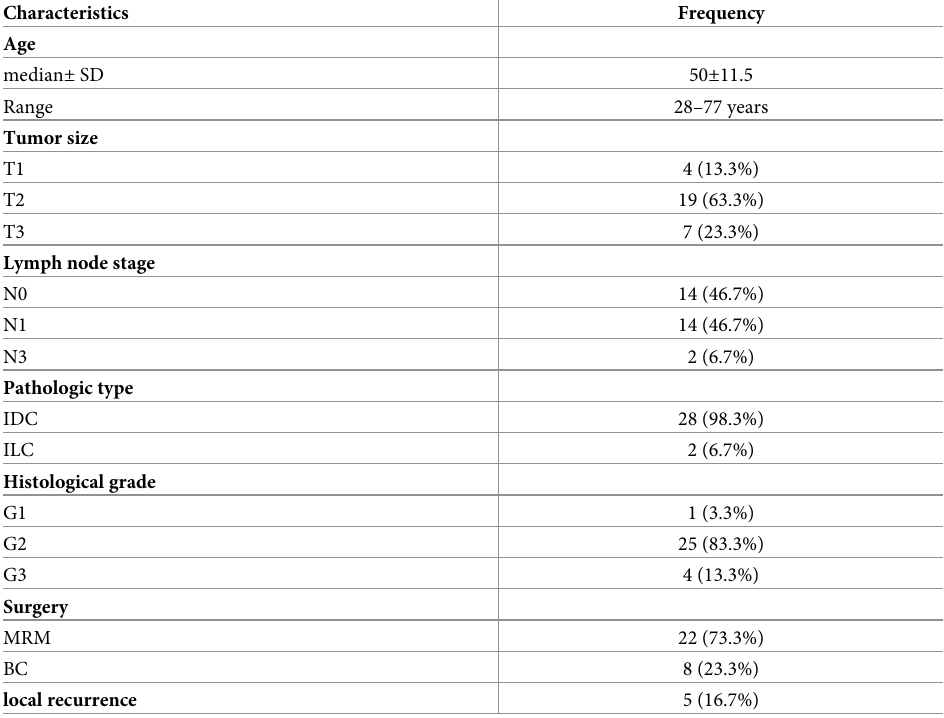
Table 1. Clinico-pathological parameters of 30 females with